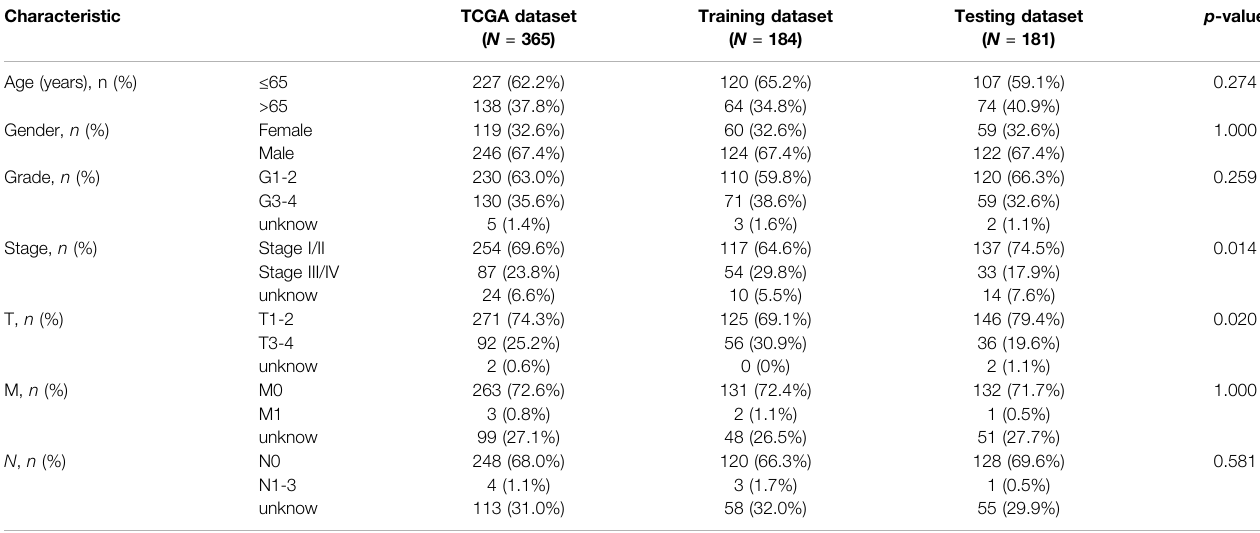
TABLE 1 | Clinical characteristics of HCC patient datasets in this study.